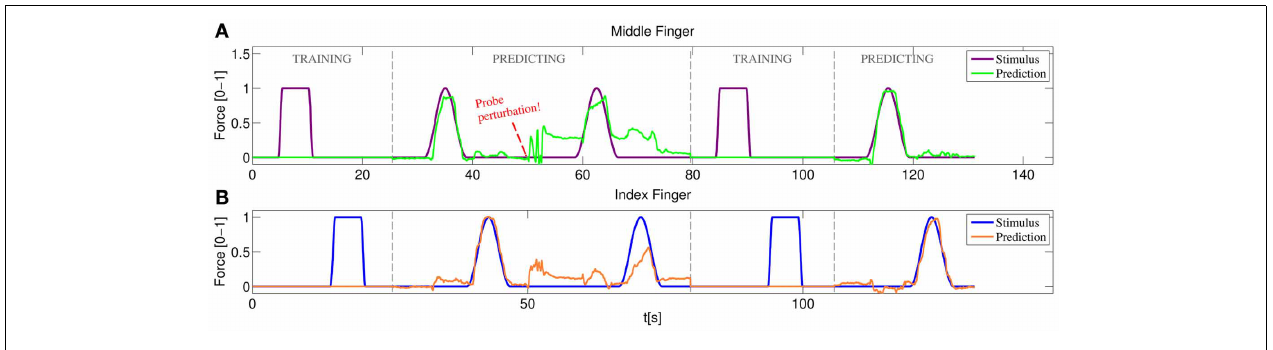
FIGURE 12 | Online training/testing for a typical subject. After a perturbation in the position of the US probe reduces the quality of the prediction, the system is set again to training and more information is fed